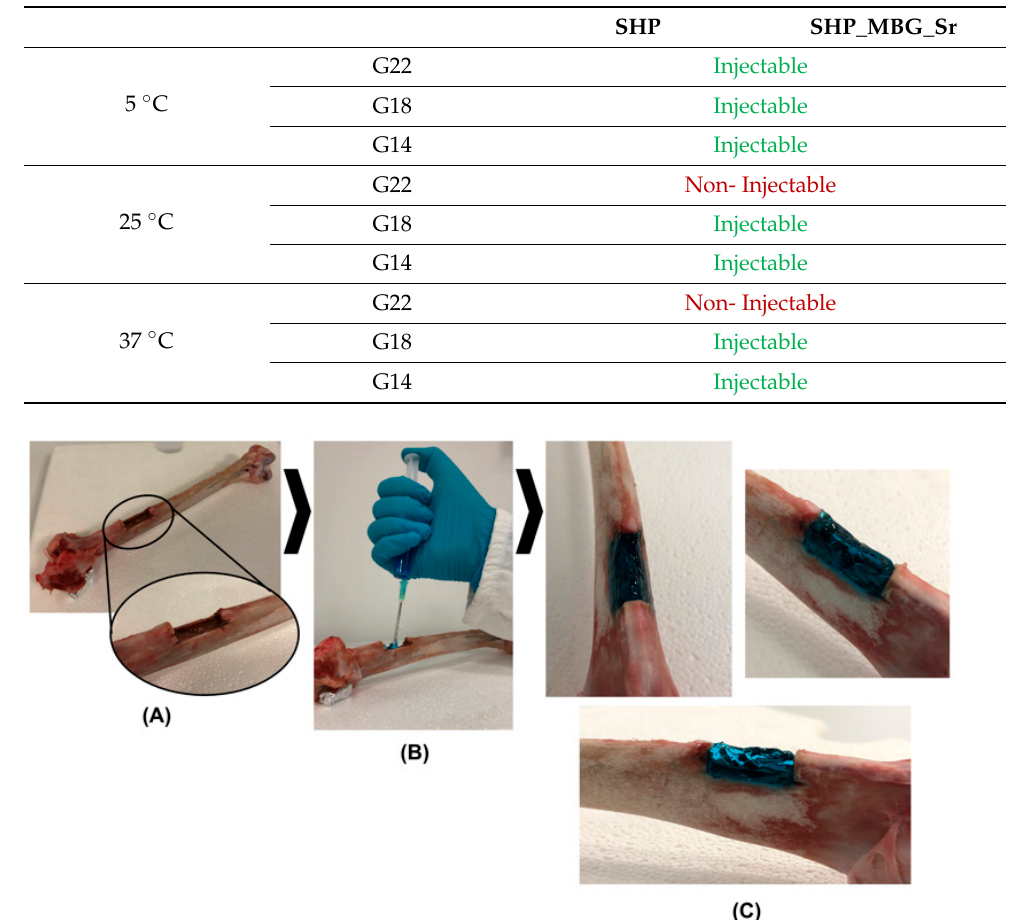
Figure 3. Qualitative ex vivo evaluation of SHP_MBG_Sr injectability in a turkey thigh bone with a manually-created defect in the diaphysis ( A ). The formulation exhibited easy injectability through a G18 needle ( B ) and the capability to perfectly fill the bone cavity while retaining its shape upon quick sol-to-gel transition ( C